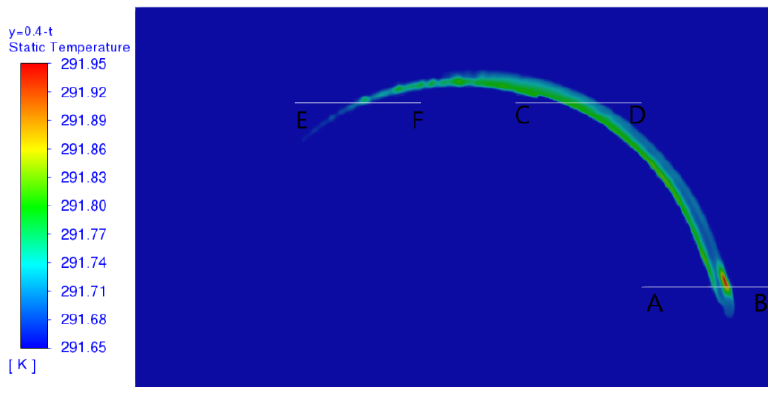
Figure 18. Surface temperature field of underwater vehicle turning 70 s. Cross sections were taken along the YZ direction at the lines AB, CD and EF, and the temperature cloud and velocity vector diagrams of the three sections are shown. The color variable is temperature. In Figure 19, the widths of the hot spot on the rotating side are 0.25 m, 0.45 m and 0.12 m, respectively, and the widths of the hot spot on the deviating side are 0 m, 0.13 m and 0.19 m, respectively.